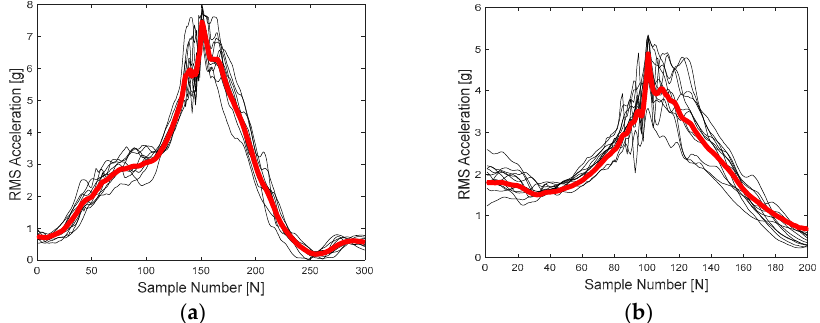
Figure 8. RMS acceleration of the wrist using IMU sensors sampled at 250 Hz: ( a ) accelerometer readings of off-spin balls; ( b ) accelerometer readings of leg-spin